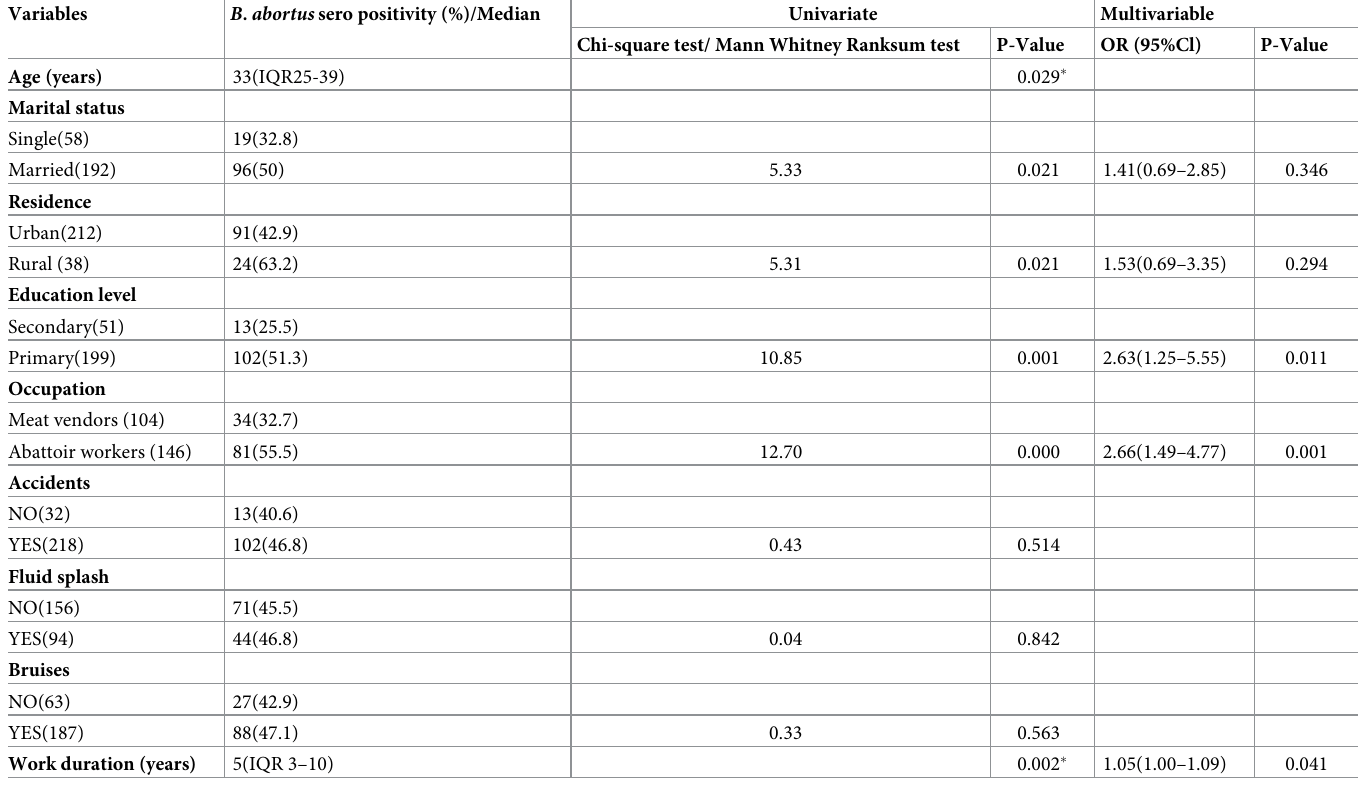
Table 2. Factors associated with B . abortus seropositivity among study participants between May and July 2017.